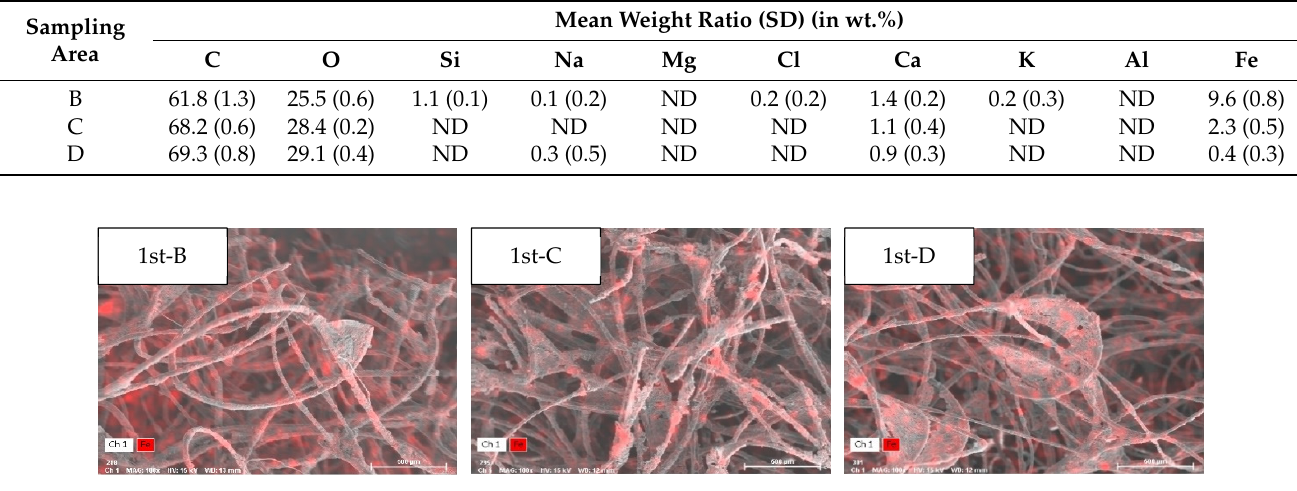
Figure 3. Element analysis of the return air through SEM-EDS on May 23.